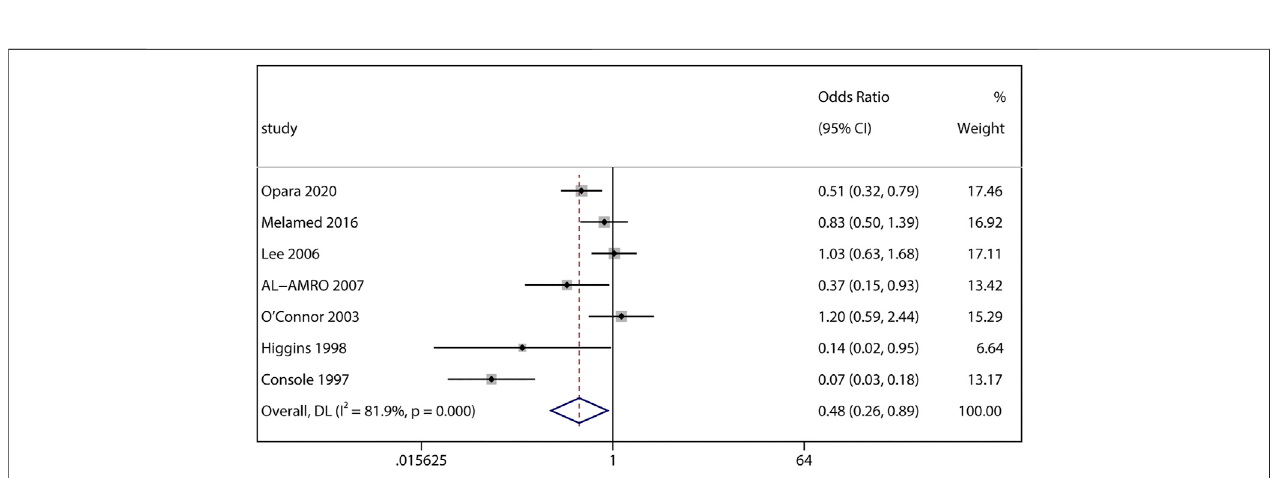
FIGURE 5 | Meta-analysis of adjusted ORs and 95% CIs for the association between antenatal corticosteroids exposure and severe retinopathy of prematurity.